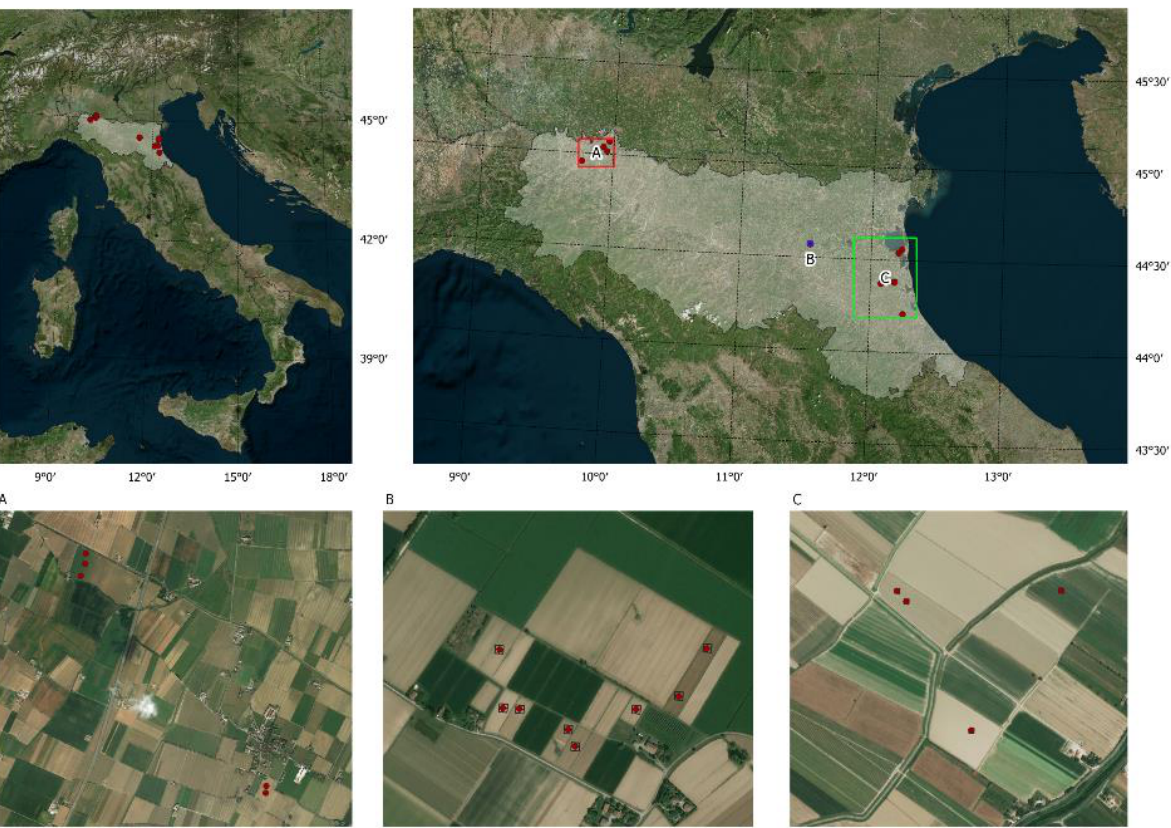
Figure 1. Study area. The study was carried out in an agricultural region located in the North of Italy: ( A ) Piacenza test site ( B ); Budrio test site; and ( C ) Ravenna test site. All the test sites are in the Emilia-Romagna region (grey shading in the top-right image).